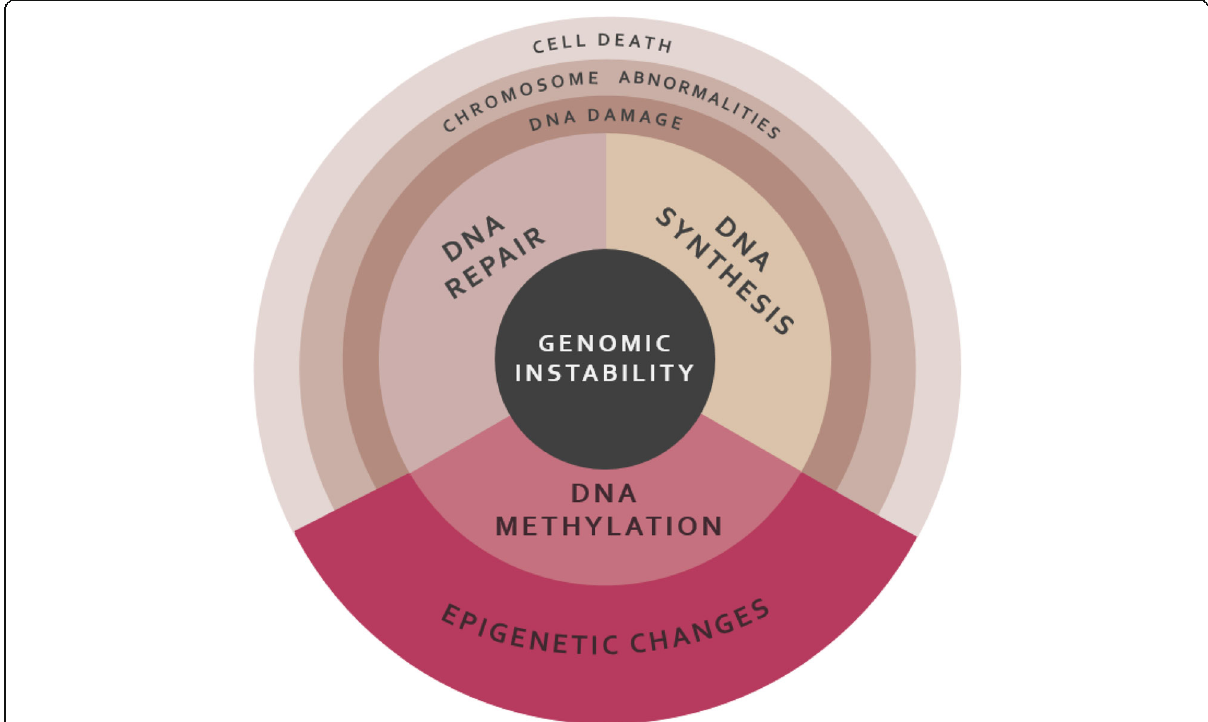
Fig. 3 Processes and consequences contributing to the genomic instability of the cell. Altered DNA synthesis, DNA repair and DNA methylation compromise the genomic stability of the cell. DNA damage and chromosomal abnormalities result from an incorrect assembly of DNA and the inability to repair errors efficiently, potentially affecting the next generation of cells or leading to cell death. If DNA methylation is disrupted, epigenetic changes affecting gene expression can occur, including incorrect methylation patterns or changes in chromatin